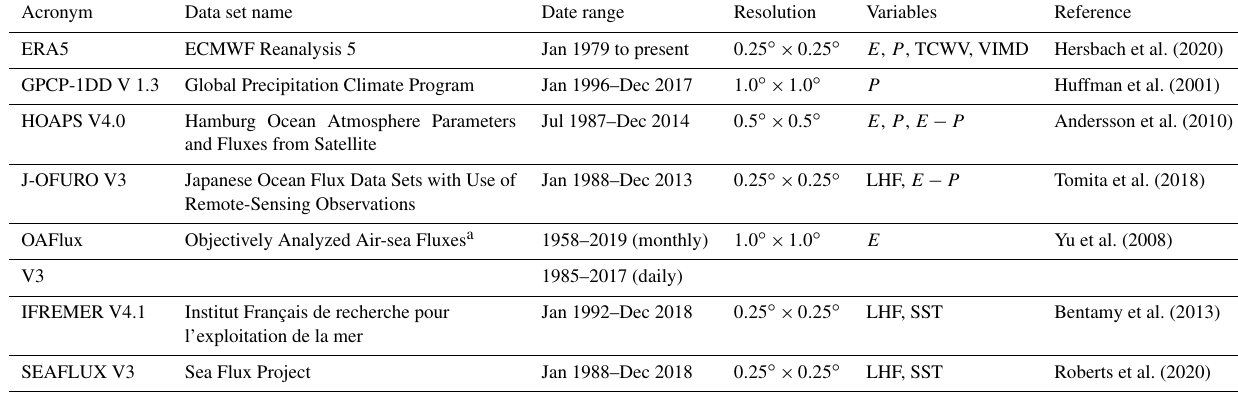
Table 1. Compilation of the data sets used within this study. Most data sets contain more variables than those listed here.